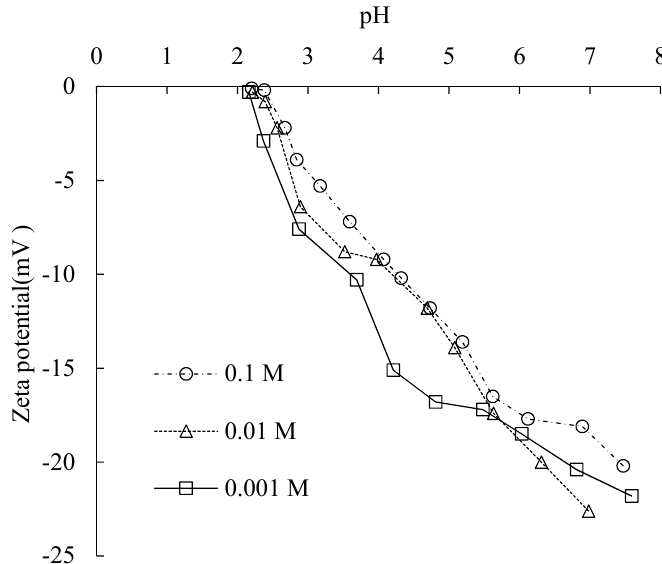
Figure 9. Zeta potential as a function of pH under di ff erent electrolyte concentrations. Colloids Interfaces 2018 , 2 , x FOR PEER REVIEW